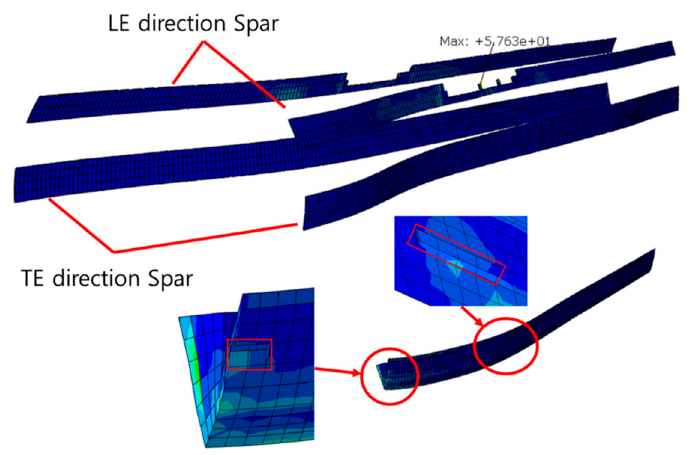
Figure 19. Crack growth shape depending on the wind blade scale: 200% of the load scale. While the durability of this model is ensured at 100% of the load scale for a general structural analysis, the adhesive failure in the joint occurred at 86% before the reference load, and the failure was progressed. As a result, the failure deteriorated progressively in the spar cap–shear web adhesive joint near the LE, approximately 12–15 m from the